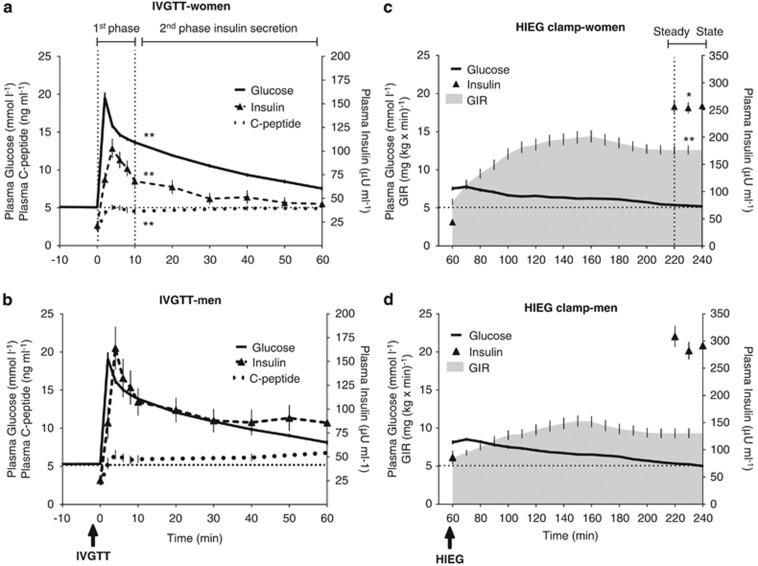
Plasma glucose, insulin and C-peptide and glucose infusion rates (GIR) during the IVGTT in women (a) and men (b) and the hyperinsulinemia euglycemia clamp (HIEG) in women (c) and men (d), the two-component test of the Botnia clamp. Sex difference at *P⩽0.05 and **P⩽0.01.